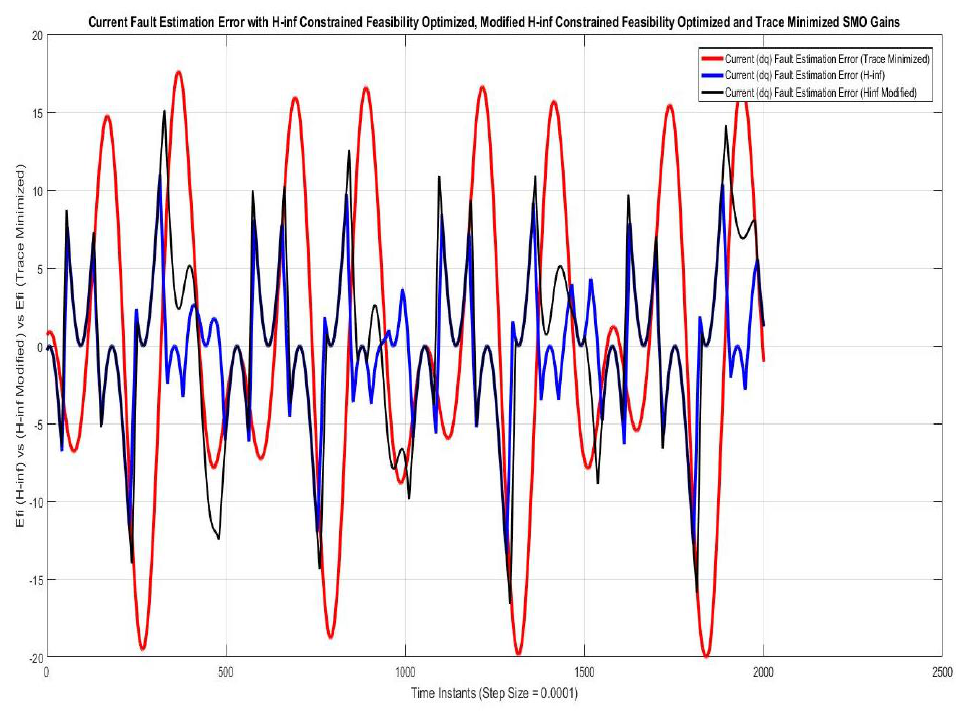
Figure 11. Current (dq) fault estimation